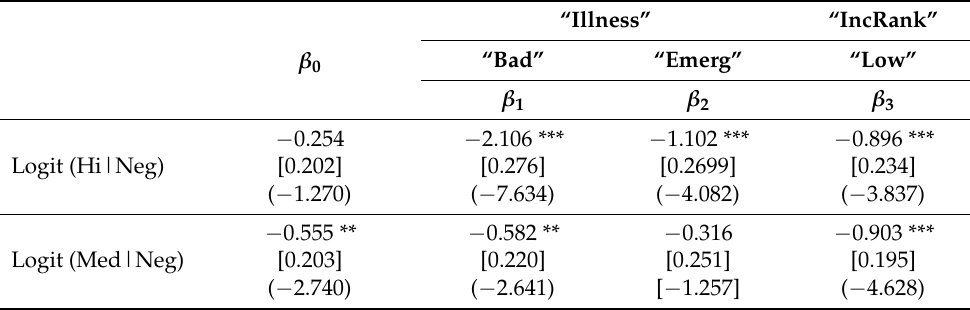
Table 11. Modelling extra thank-you money against illness and income rank. “Illness” “IncRank” “Bad” “Emerg” “Low” β 0 β